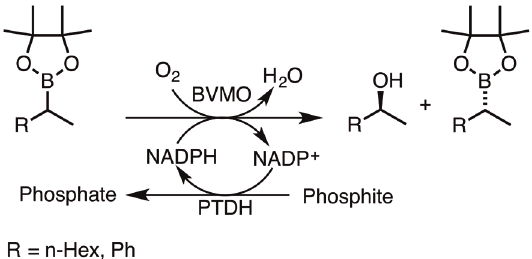
Figure 50 - Oxidation of chiral boranes to alcohols by